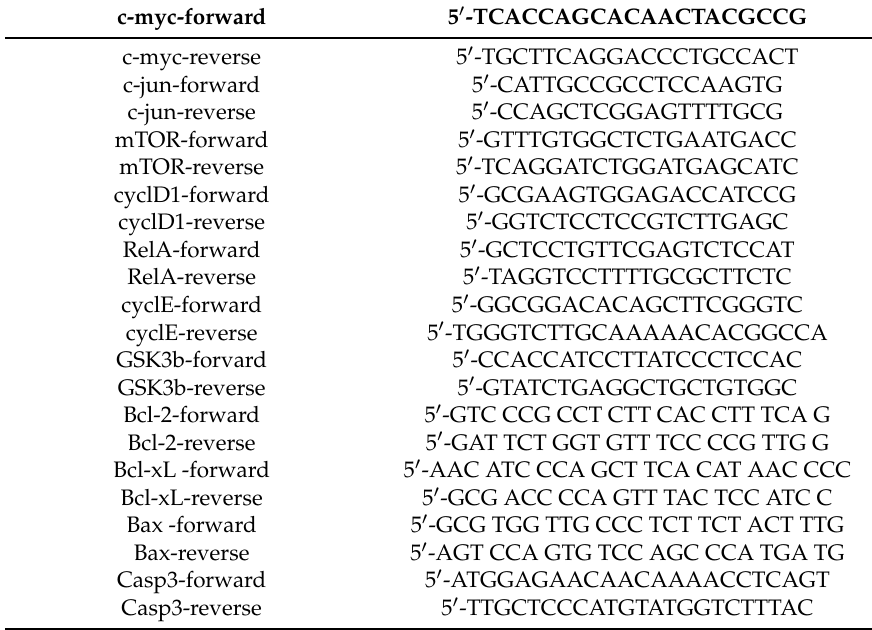
Table 1. The sequences of the primers used to real-time